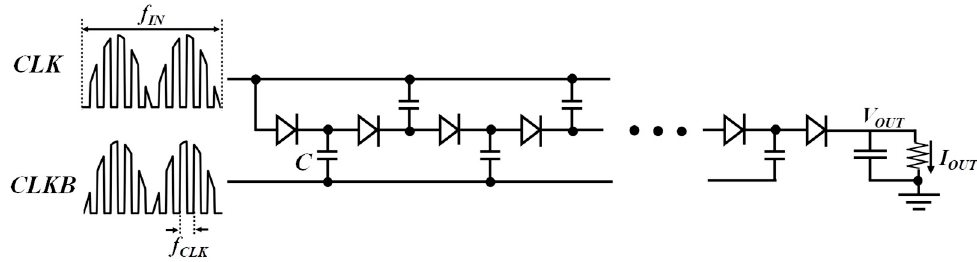
Figure 5. Clocked AC-DC CP.